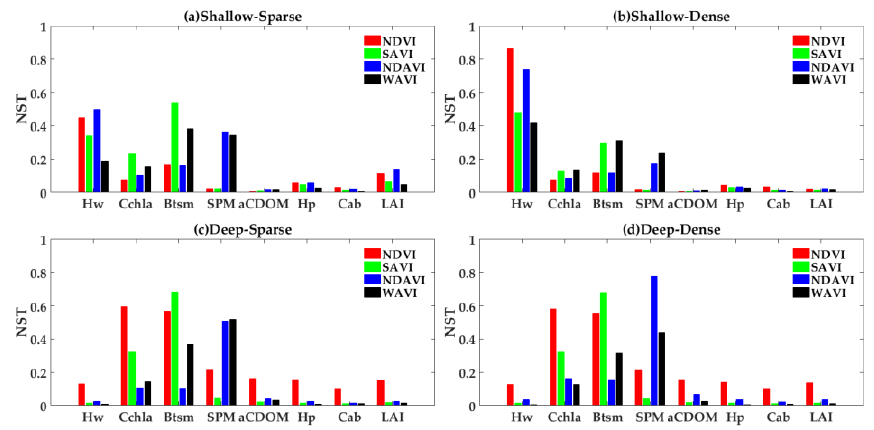
Figure 8. The NST of high sensitivity parameters to vegetation indices for submerged vegetation. ( a ), ( b ), ( c ), ( d ) represent the cases of shallow-sparse, shallow-dense, deep-sparse and deep-dense, respectively.